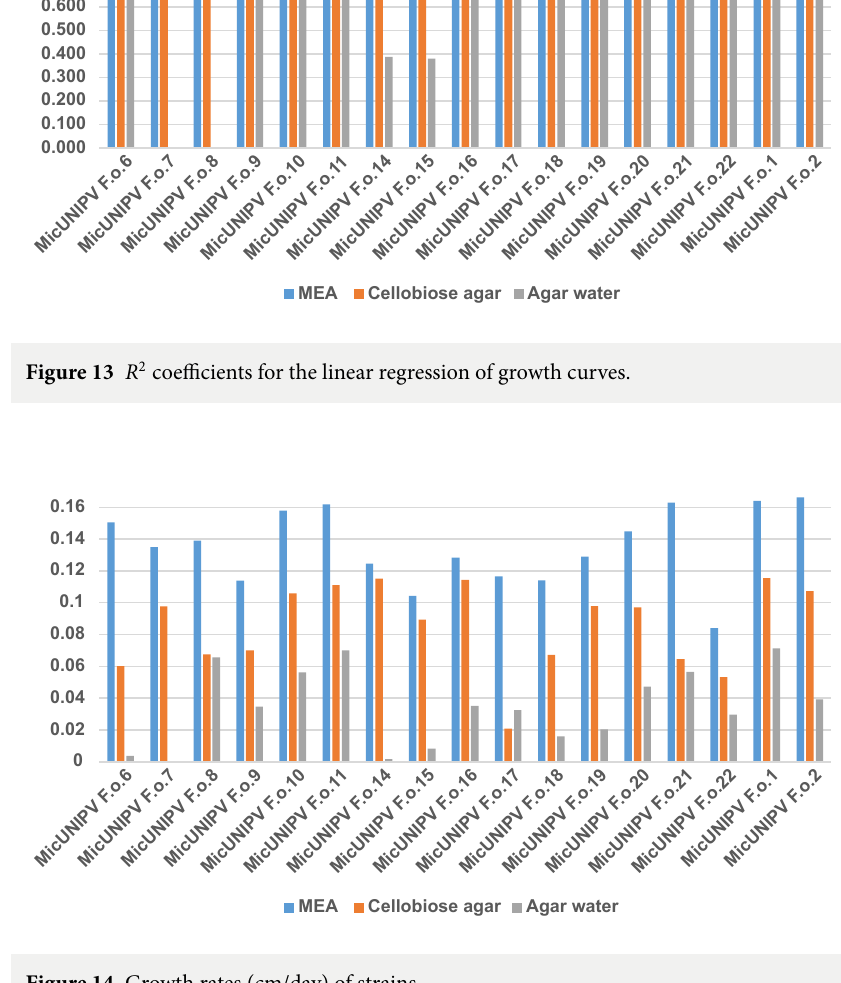
Figure 14 Growth rates (cm/day) of